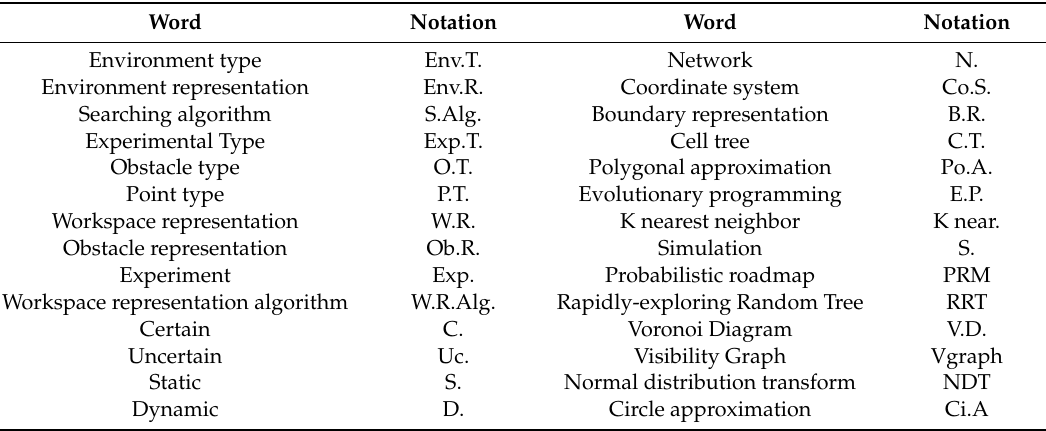
Table 1. Shorthand notation for the tables.